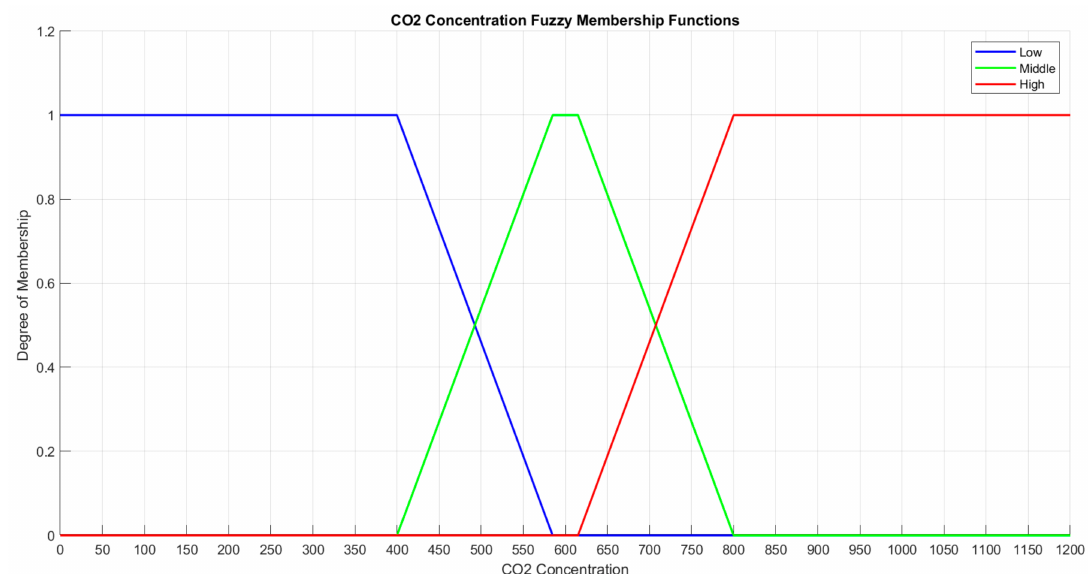
Figure 14. CO 2 concentration fuzzy membership